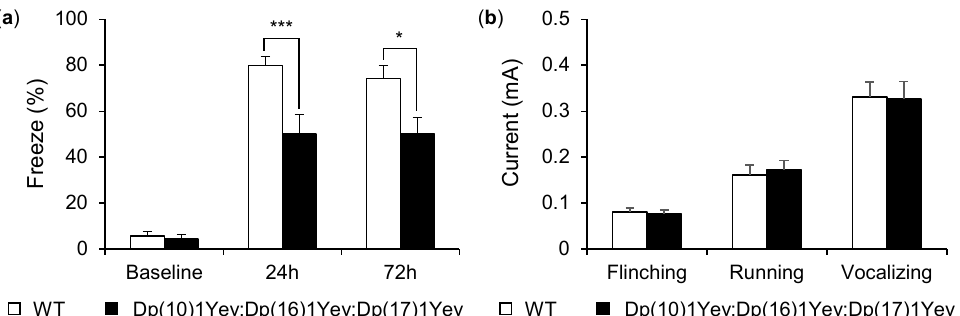
Figure 7. Contextual fear-condition test and foot-shock sensitivity test: ( a ) Dp(10)1Yey;Dp(16)1Yey;Dp(17)1Yey mice and the wild-type control mice were placed in the testing chamber for 2 min, and a 2-s foot-shock was delivered at the end of the period. Dp(10)1Yey;Dp(16)1Yey;Dp(17)1Yey mice and the wild-type control mice exhibited no significant difference at the baseline freezing level ( p = 0.67). Then, mice were placed back into the chamber 24 and 72 h afterward. After 24 h, Dp(10)1Yey;Dp(16)1Yey;Dp(17)1Yey mice froze significantly less than the wild-type control mice ( p = 0.003). After 72 h, Dp(10)1Yey;Dp(16)1Yey;Dp(17)1Yey mice still froze less than the wild-type control mice ( p = 0.014). ( b ) A foot-shock sensitivity test was performed on both groups of mice. The minimum currents required to induce flinching, running, or vocalizing were similar for Dp(10)1Yey;Dp(16)1Yey;Dp(17)1Yey mice and the wild-type control mice. * p < 0.05; *** p < 0.005.